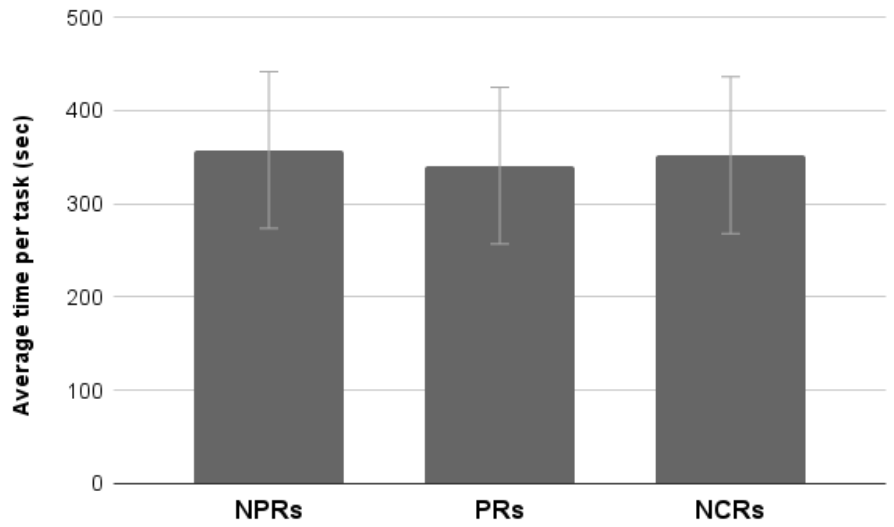
Figure 19. Average time per task by Group (NPRs vs. PRs vs. NCRs). Error bars denote 0.95 confidence intervals.